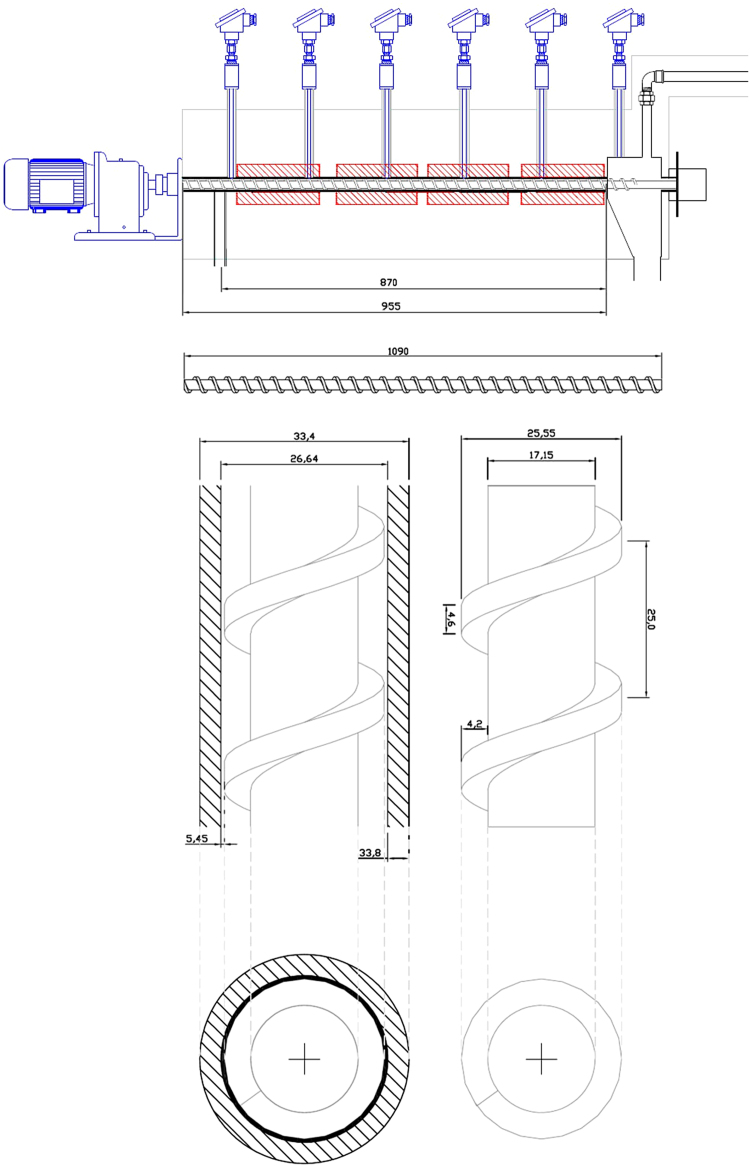
Reactor dimensions.